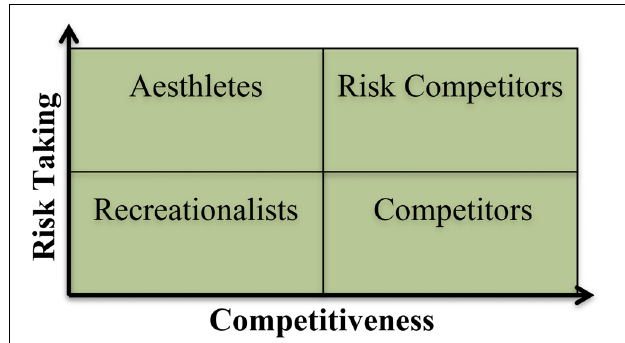
FIGURE 4 | Proposed model of mountain biking identity